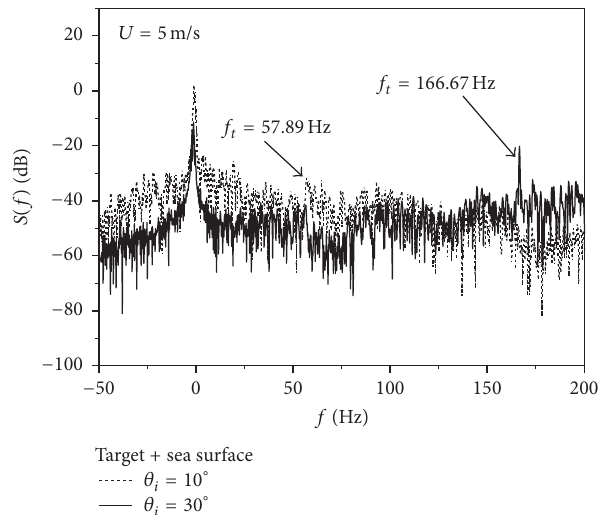
Figure 6: Doppler spectra from different incidence angles.